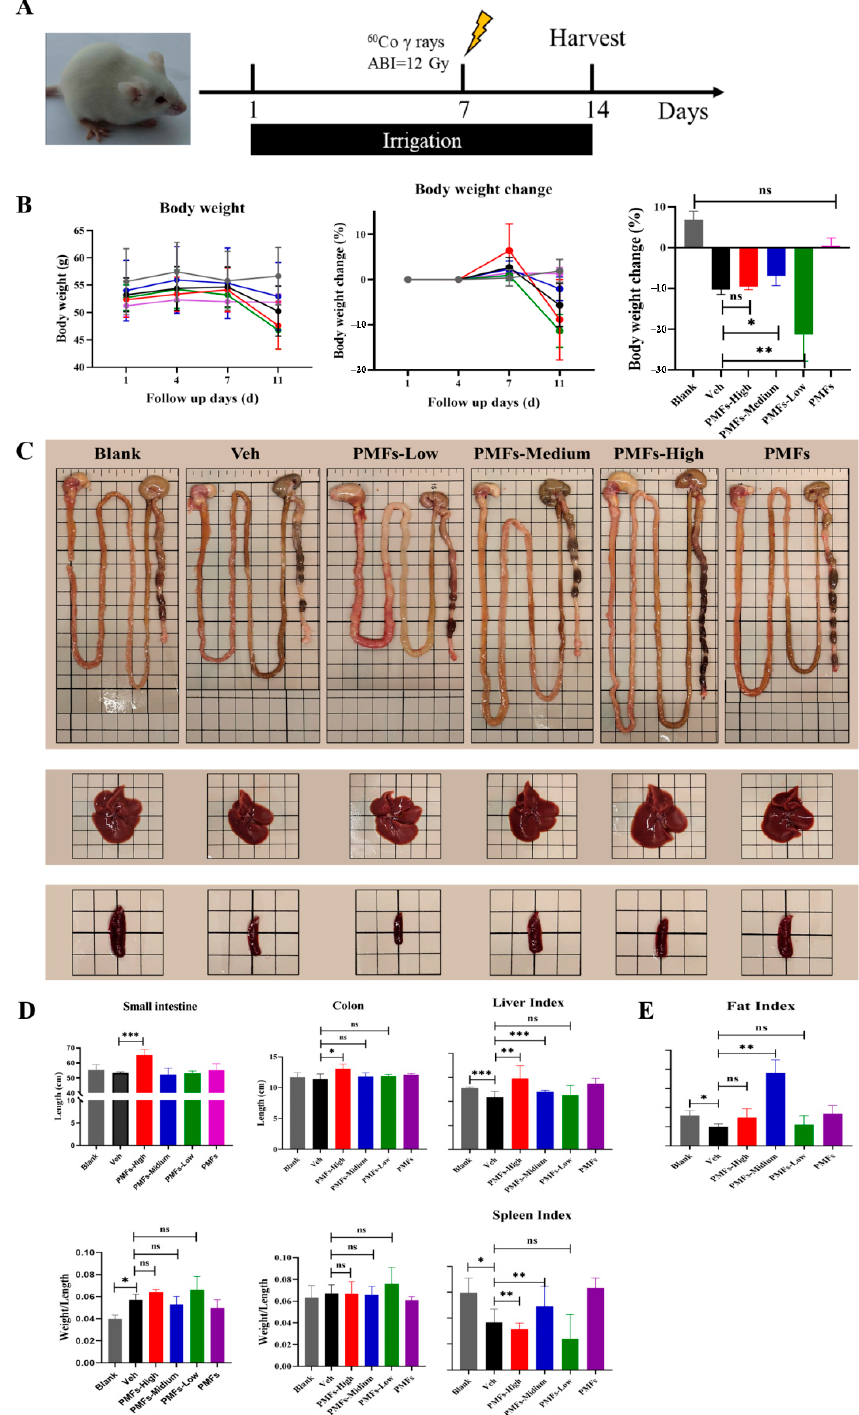
Figure 4. The protective effects of PMFs on irradiation-induced injury. ( A ) Experimental design. ( B ) Body weight change of mice during the experiment. ( C ) Major intraperitoneal organs of differently treated mice. ( D ) Organ indexes of mice. ( E ) Fat mass index of mice. * p < 0.05; ** p < 0.01; *** p < 0.001. ns, not significant.